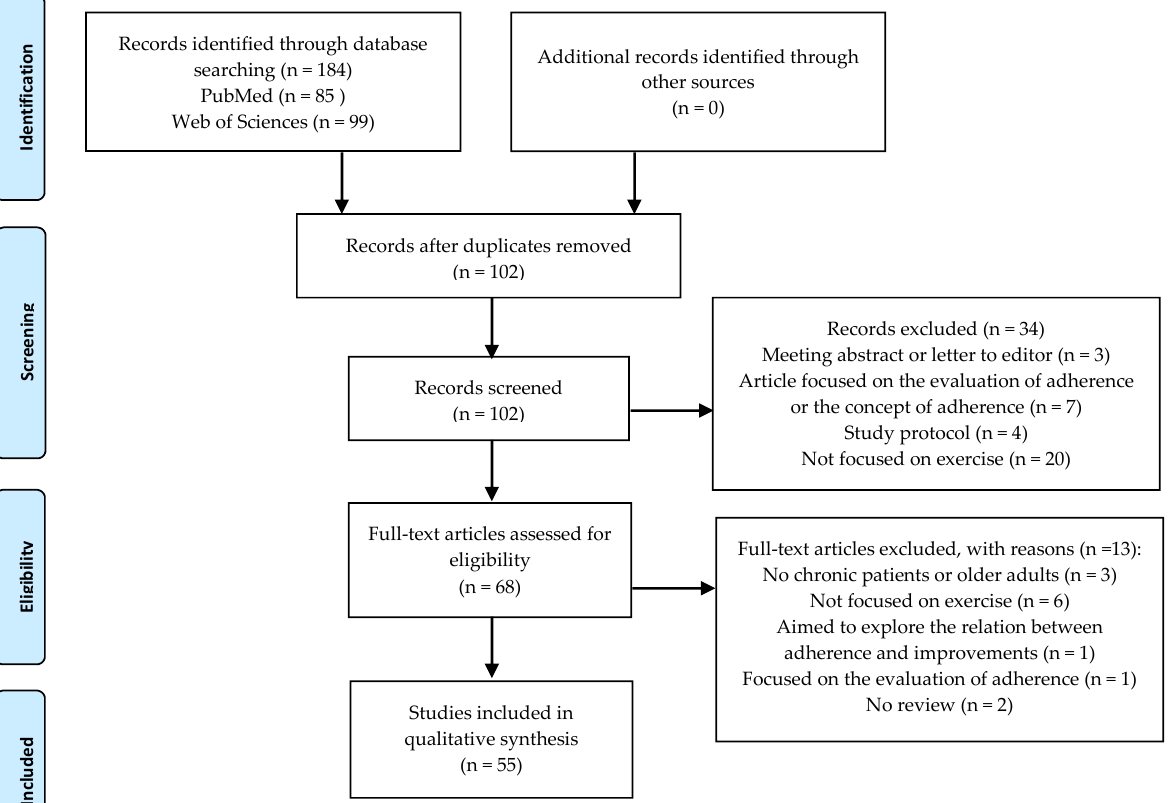
Figure 1. Flow diagram of the selection process. Table 1. Summary of the sample characteristics, type of exercise, and number of reviews identified for each sample and exercise type.